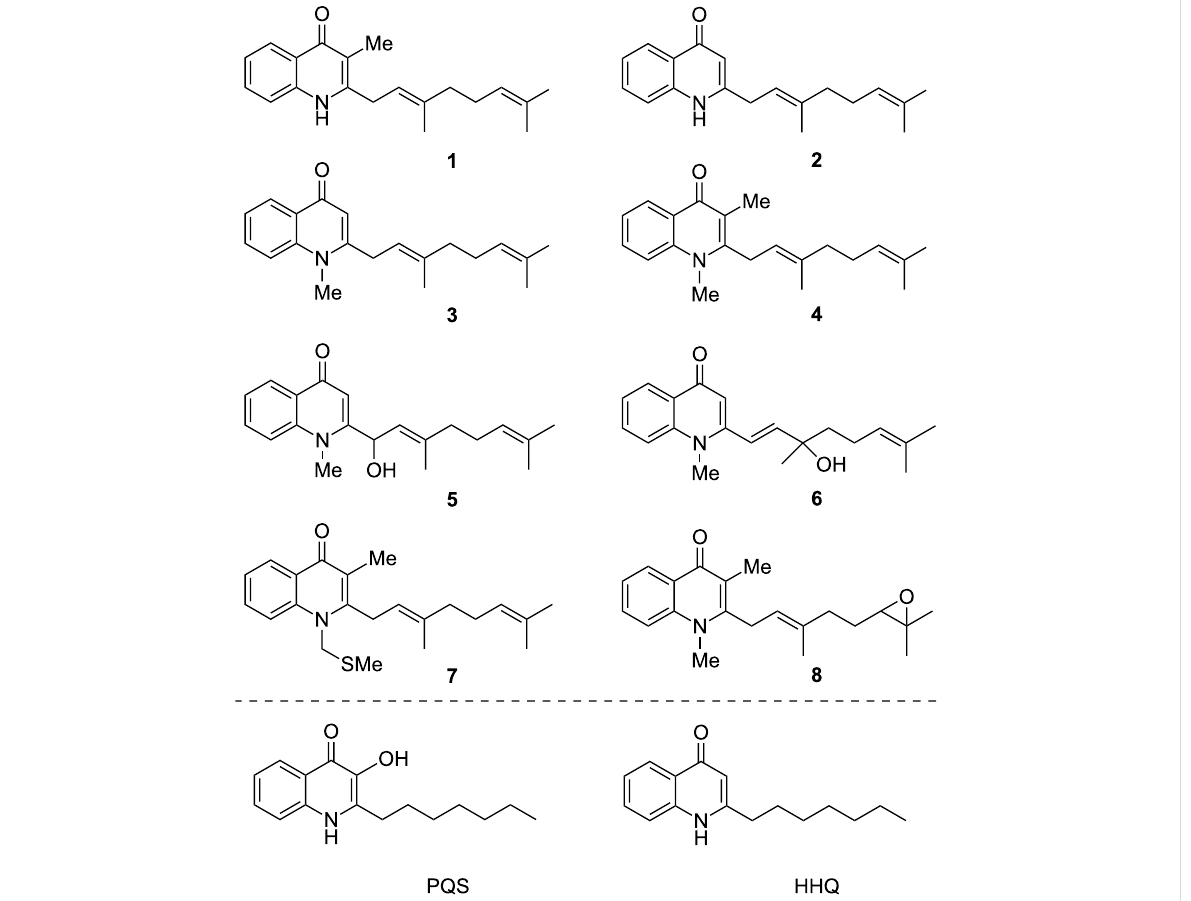
Figure 1: A family of quinolone natural products 1 – 8 , which were first isolated from Pseudonocardia sp. CL38489 by Dekker et al. [3], shown along- side the structure of the Pseudomonas quinolone signal (PQS), a key autoinducer used in quorum sensing signalling by the human pathogen Pseudomonas aeruginosa , and 2-heptyl-4(1 H )-quinolone (HHQ), the biosynthetic precursor of